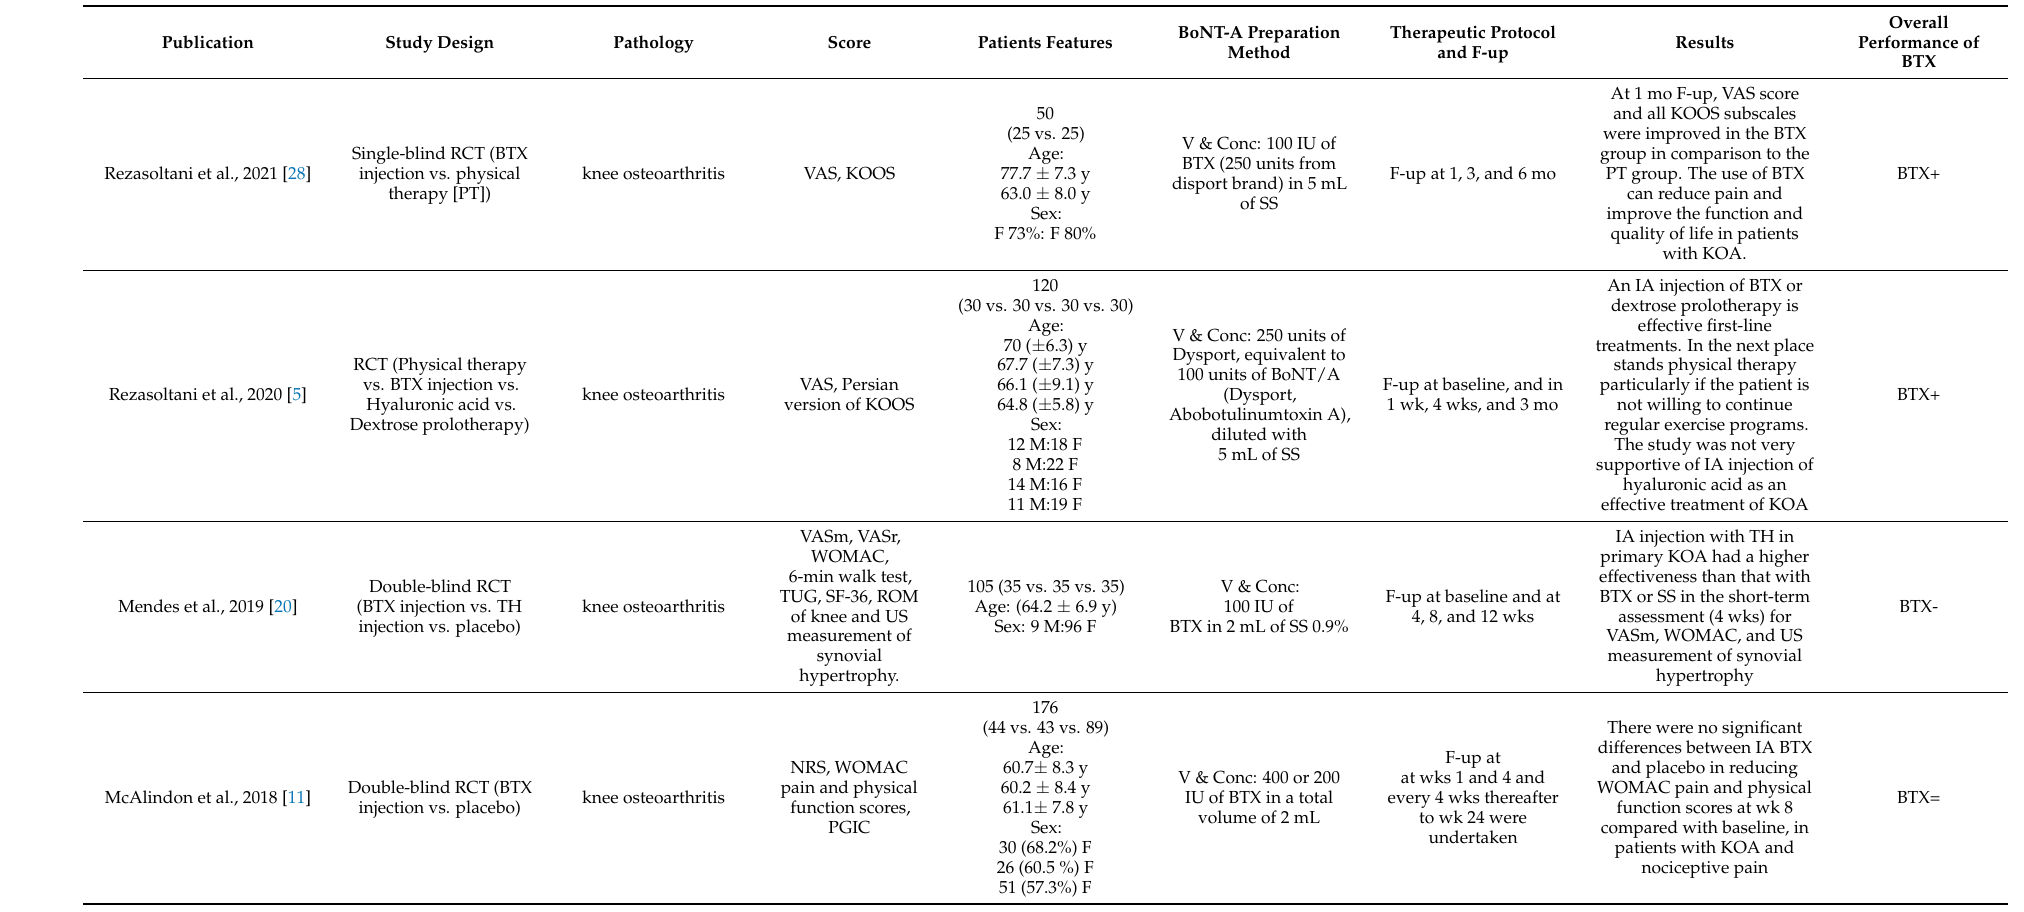
Table 1. The use of botulinum toxin in the treatment of KOA: data extracted from the 9 RCTs included in the